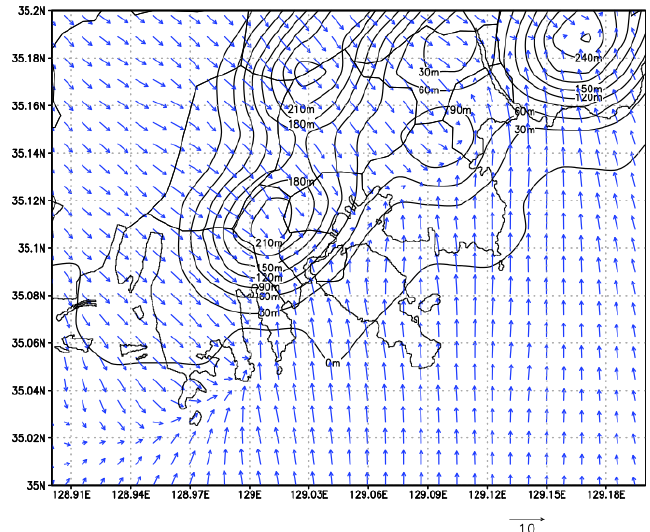
Figure 7. ( a ) Annual mean PM 2.5 concentrations (µg/m 3 ) at air quality monitoring sites in 2020 and ( b ) PM 2.5 contribution concentrations (µg/m 3 ) from ship emissions.